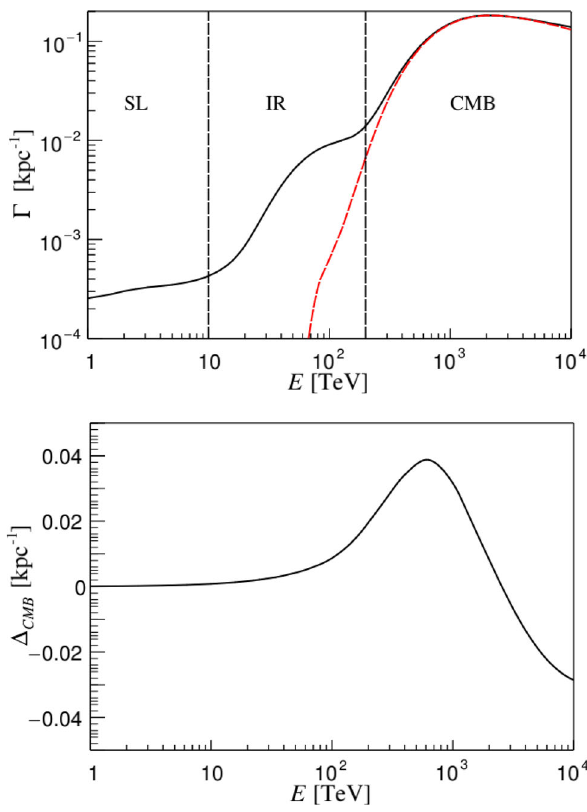
Fig. 3 Upper panel: VHE photon absorption rate as a function of the photon energy E for the host galaxy (red dashed curves) and the Milky Way near the Sun, using the dn bkg γ / d (cid:4) in Ref. [84] (black continuous curves). Lower panel: (cid:11) CMB factor as a function of the photon energy E obtained with Eq. (14) E × (cid:11) = CMB π